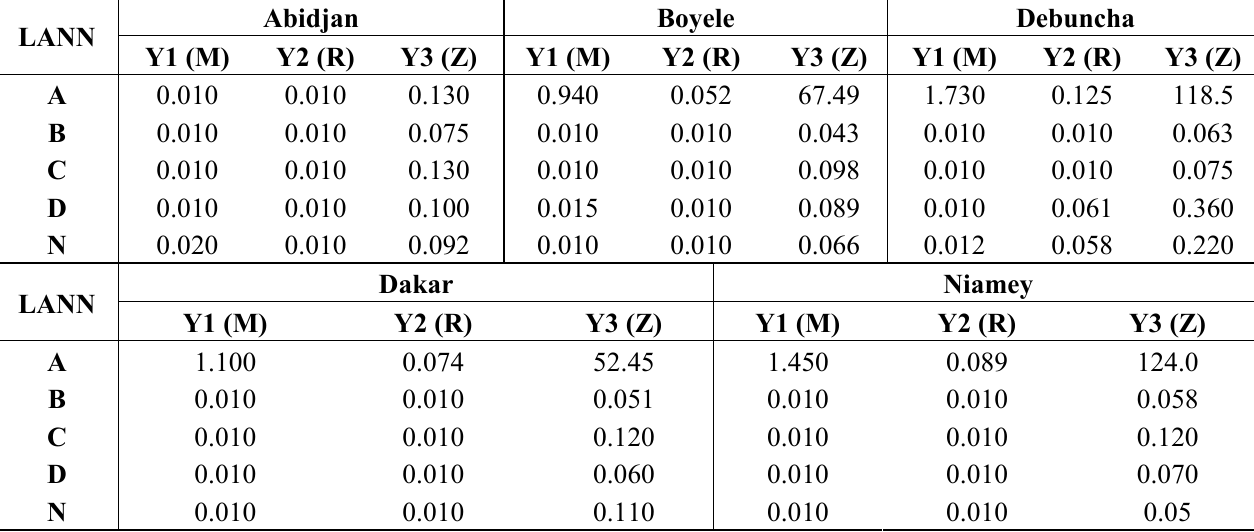
Table 7. Comparisons between RMSE after use of the different LANN: Case of stratiform